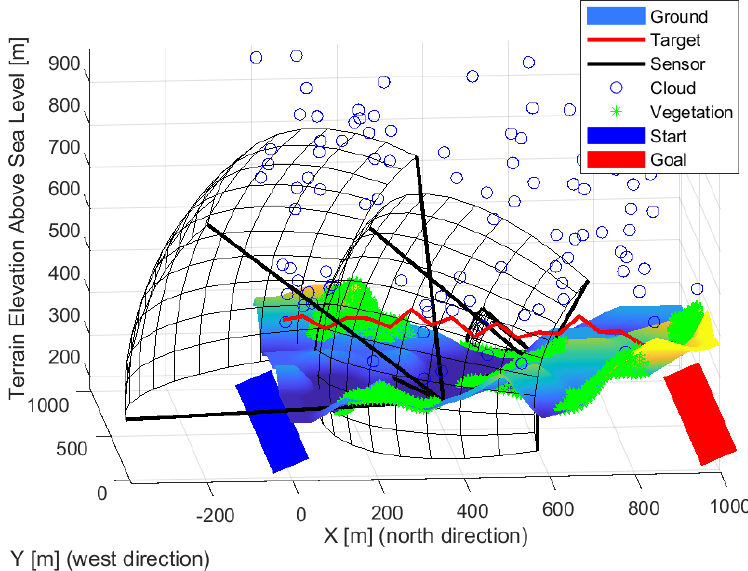
Figure 10. The solution in the case of the three sensors from the side view.